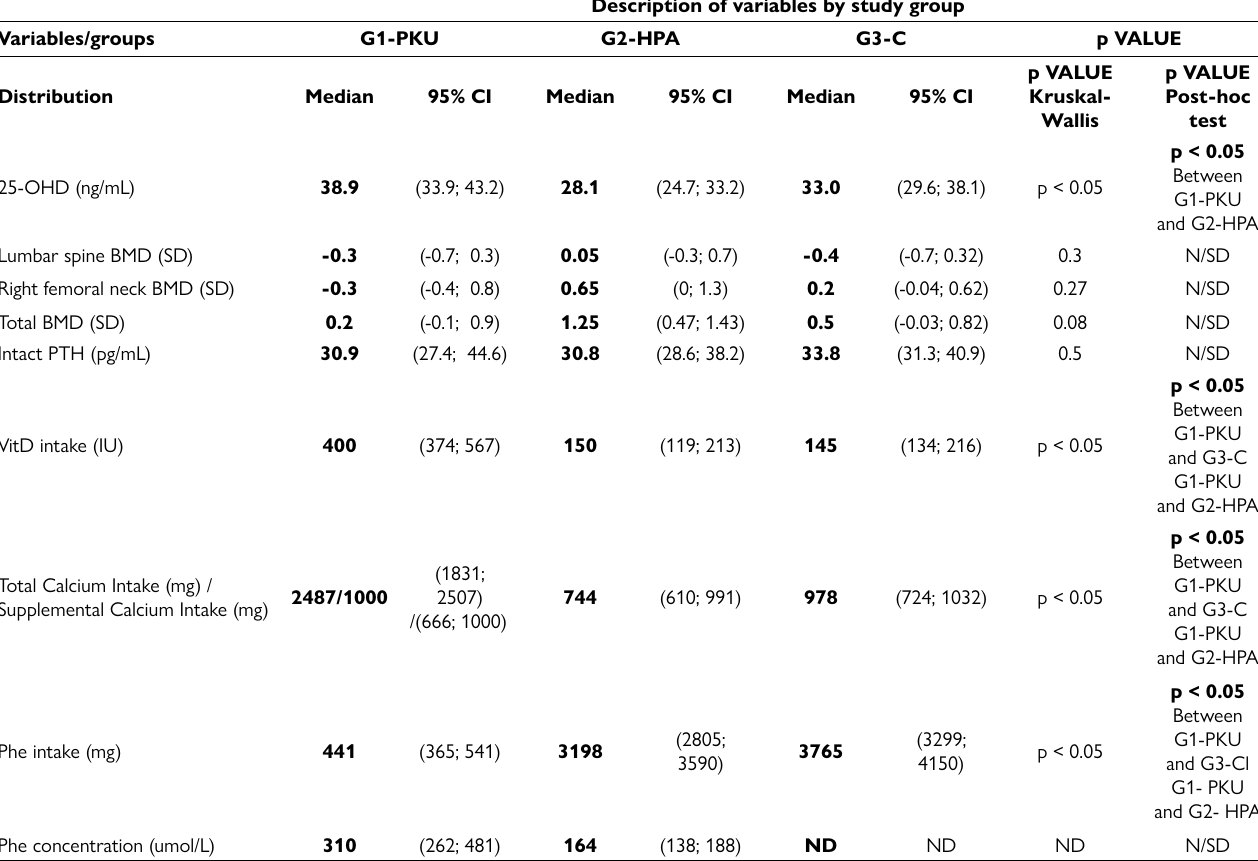
Table 2. Characteristics of the dependent variables according to study groups.